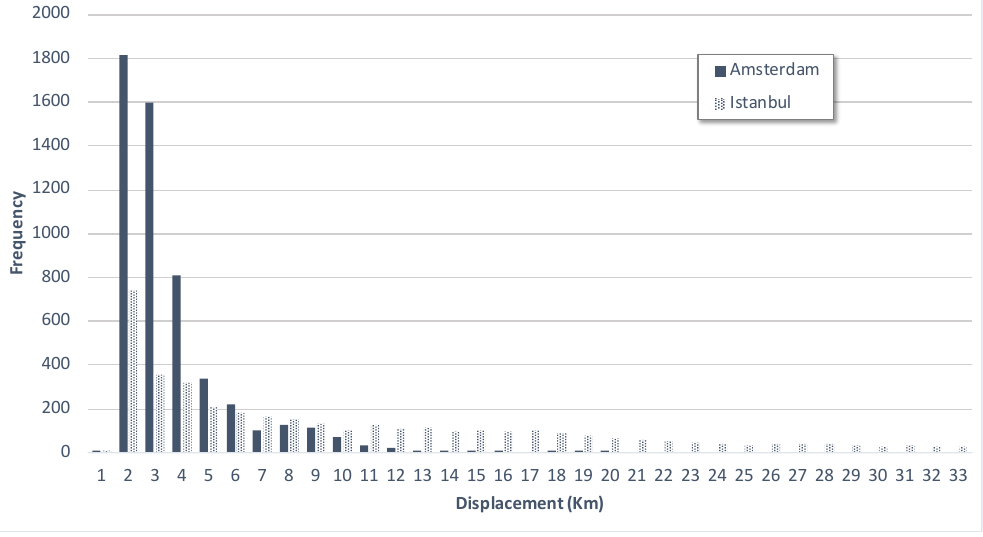
Figure 14. Bar chart visualizing the frequency of displacements (average distance between posts in kilometers) in Amsterdam and